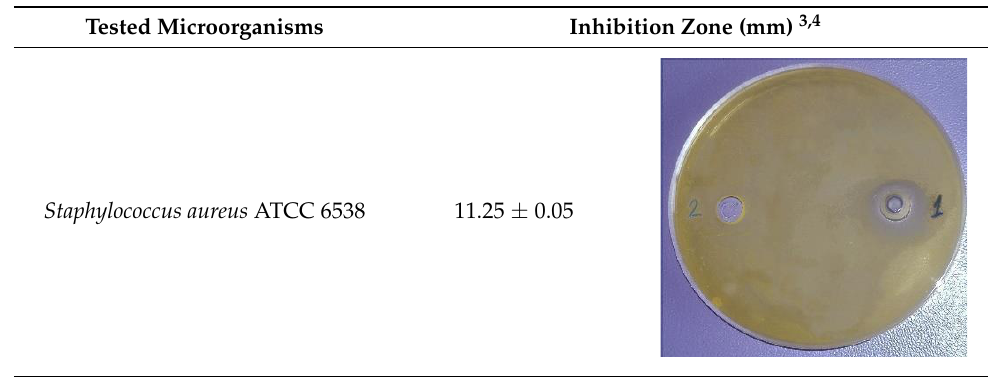
Table 3. Antimicrobial activity of EOs from Vitex fruits (sample 2 from north-central Bulgaria) 1,2 .